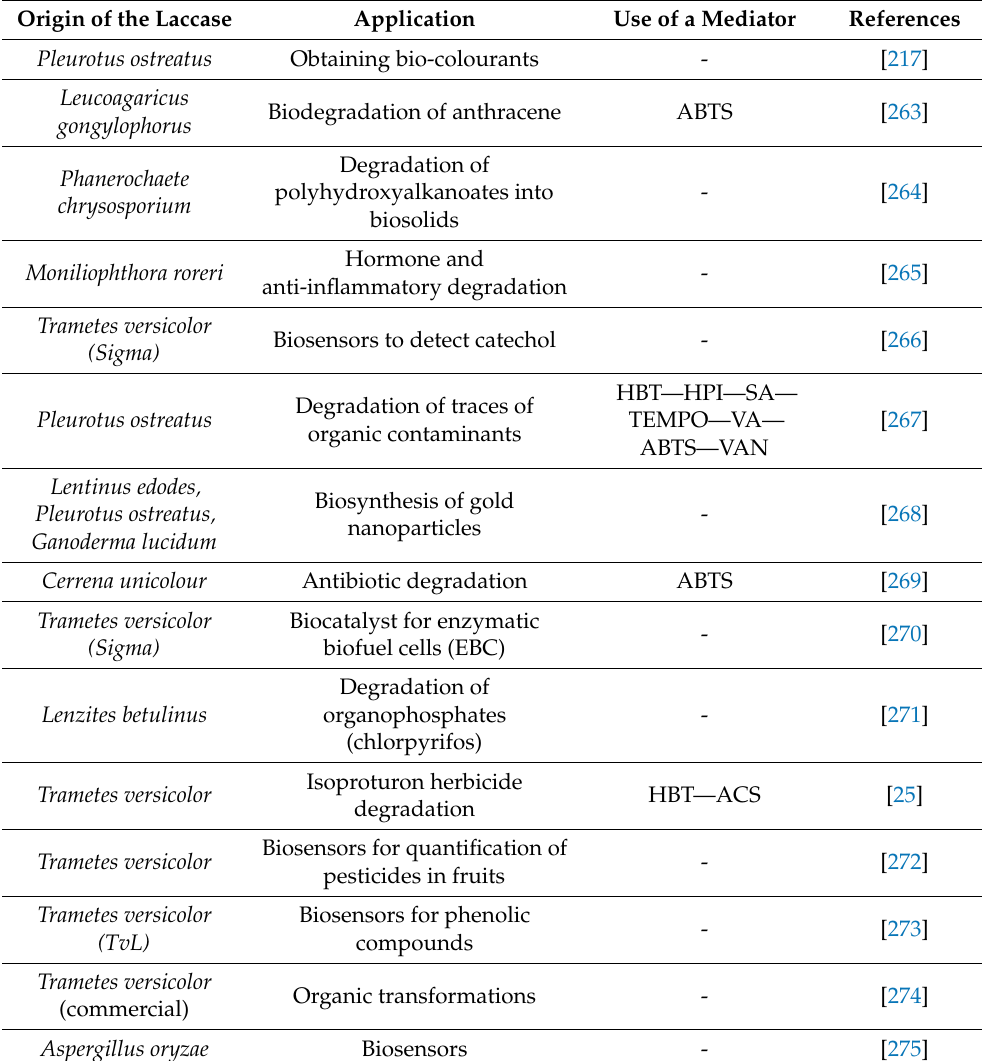
Table 7. Some applications of